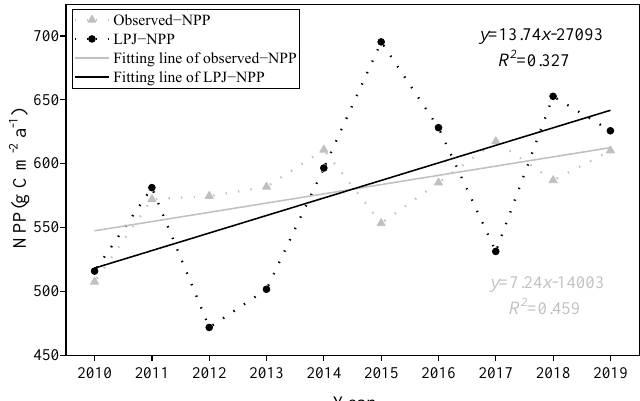
Figure 8. Interannual variation of Larix olgensis forests NPP simulated by the LPJ model and the MODIS NPP from 2010 to 2019.